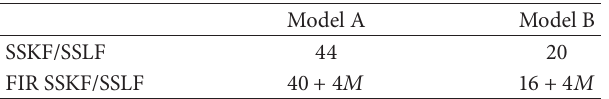
Table 6: Calculation burden of classical and FIR steady state filters implementations.